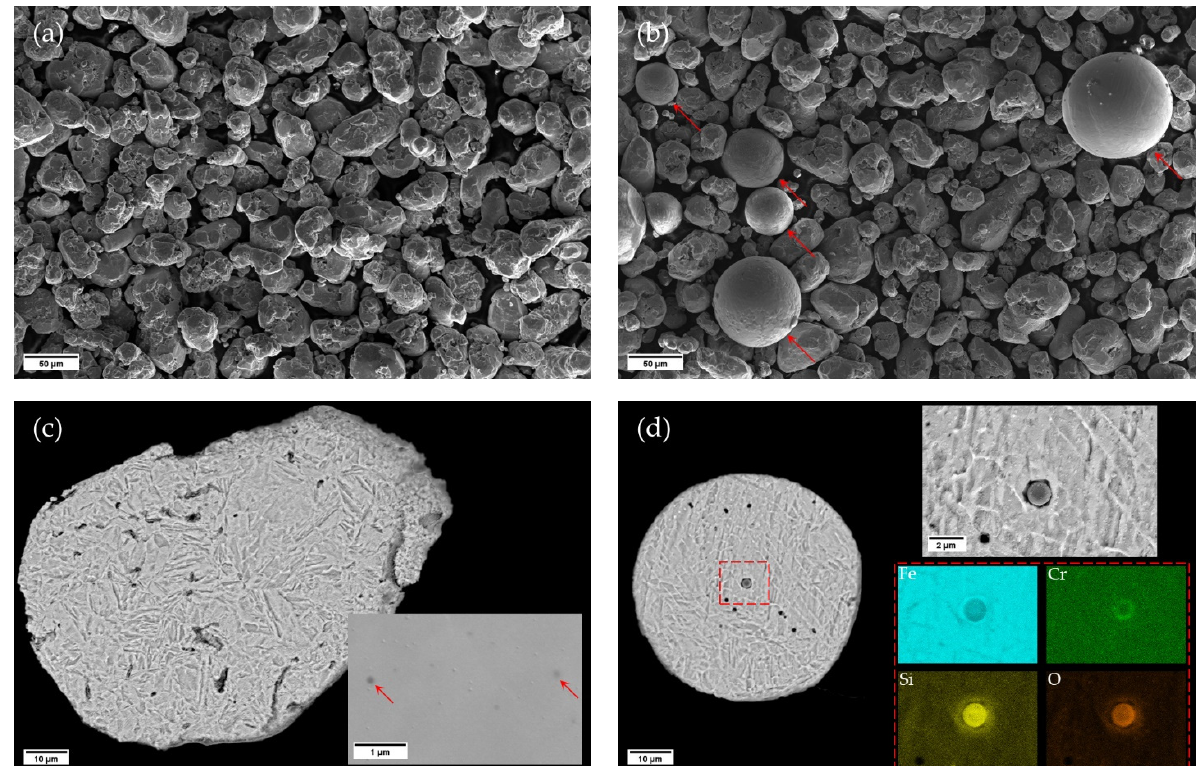
Figure 2. FE-SEM micrographs showing ( a ) virgin powder and ( b ) run #1 powder. Microstructure of ( c ) virgin powder particle and ( d ) spatter particle collected from run #4.